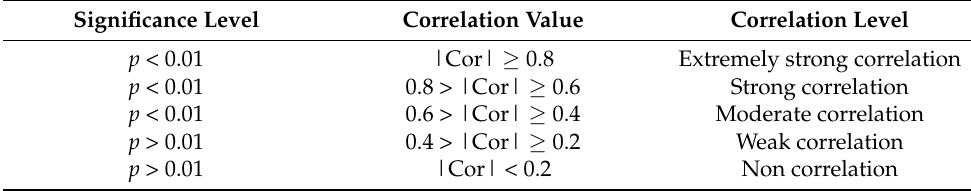
Table 3. Rules of correlation